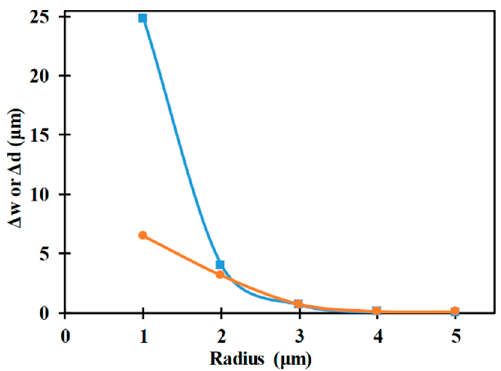
Figure 11. Variation of ∆ w ( (cid:4) ) and ∆ d ( (cid:8) ) with microparticle radius ( W e = 80 µ m, L e = 2000 µ m, L ch = 2200 µ m, V 1 = V 2 = 12 V pp , W ch = 200 µ m, H ch = 50 µ